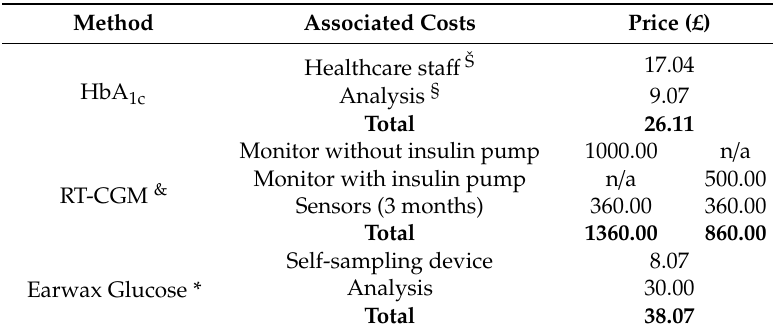
Table 6. Estimated costs related to di ff erent sampling methods for measuring chronic glucose over a three-month period in the UK.